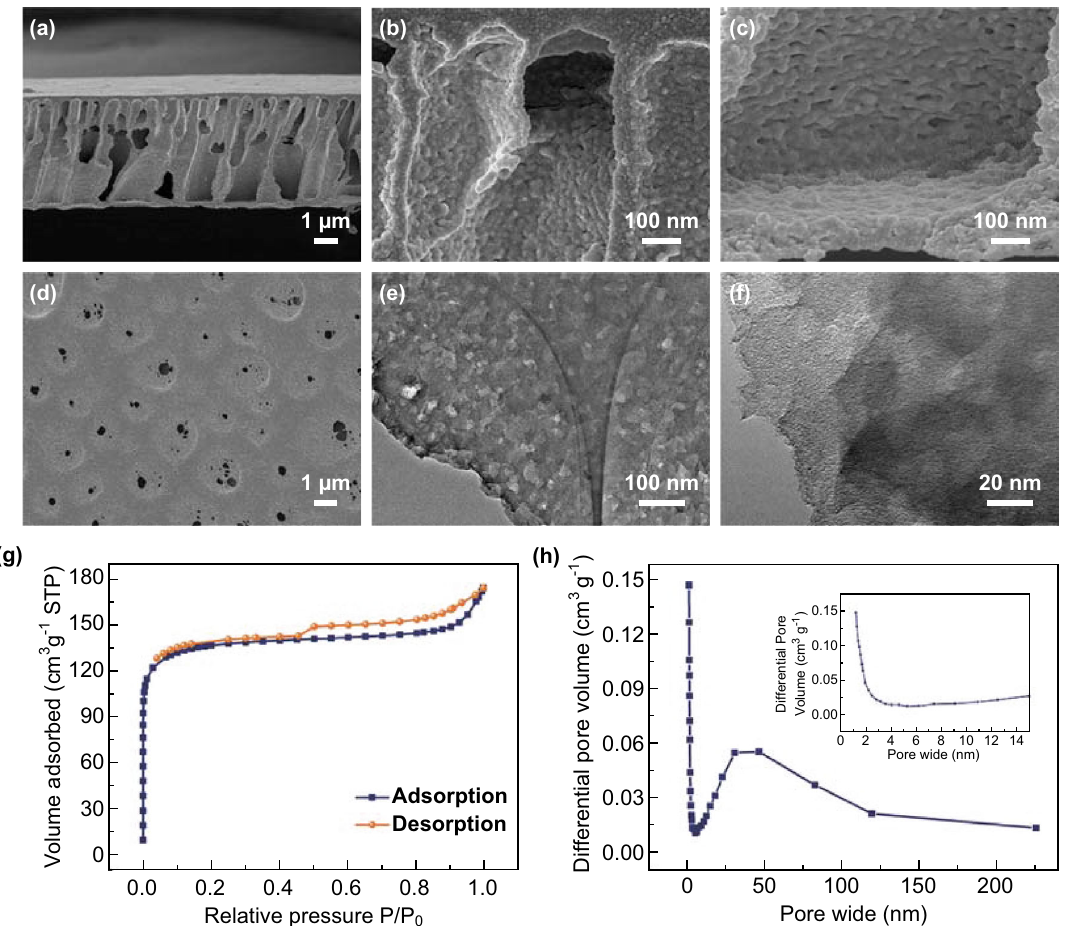
Fig. 1 SEM images of the VN/C (I): a – c cross-sectional views and d surface view. e , f TEM images of the VN/C (I). g , h N 2 adsorption– desorption isotherms and pore size distribution of the VN/C